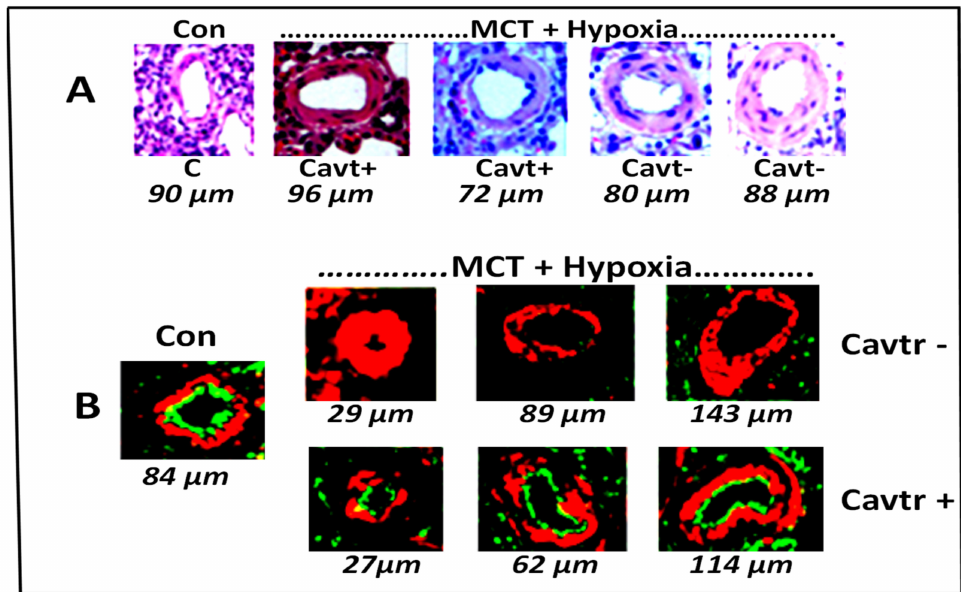
Figure 3. ( A ) Pulmonary artery (size 72–96 µ m) histology in C (controls), Cavtr+ (M + H+ cavtratin) and Cavtr– (M + H). The artery in the control is thin walled. In the M + H group the arteries appear thickened. In the cavtratin-treated group, the arteries appear less thickened. ( B ) Immunofluorescence study: Caveolin-1 (green) and smooth muscle α -actin (red) in pulmonary arteries (size 27–143 µ m). There is significant loss of endothelial caveolin-1 in MCT + hypoxia group, and cavtratin-treated rats show recovery of endothelial